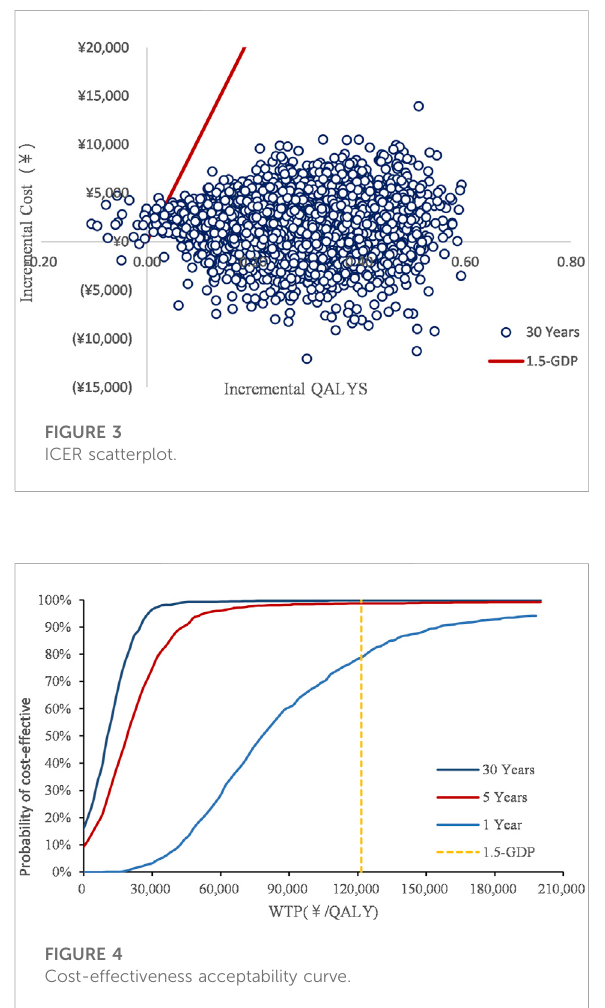
FIGURE 4 Cost-effectiveness acceptability